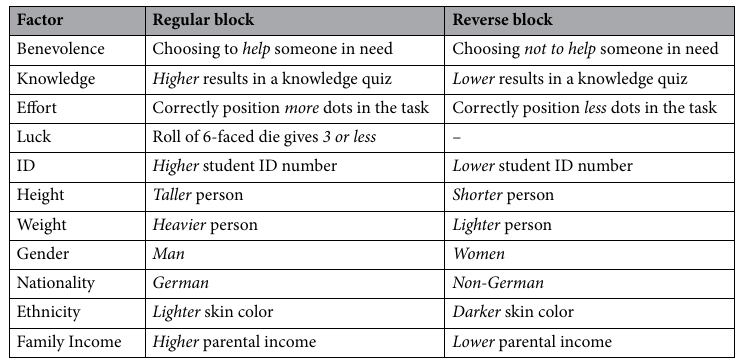
Table 1. Criteria for receiving higher chances in the Regular and Reverse blocks. Notes: We did not reverse Luck because this would simply mean changing the winning numbers of the die roll, which should have no effect on its fairness and control